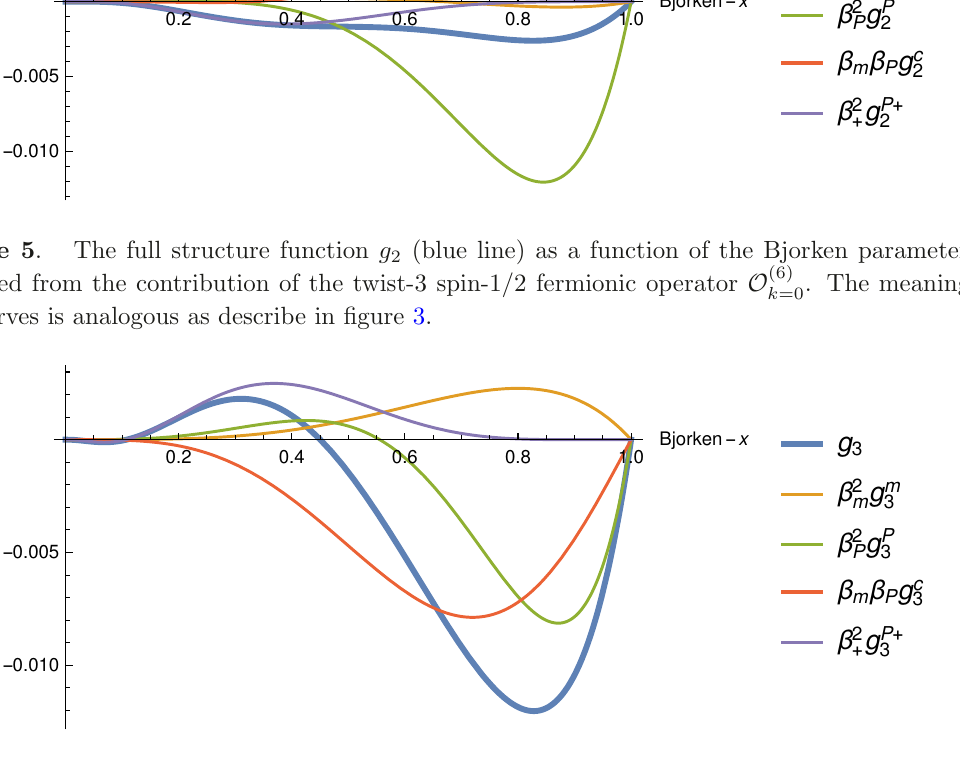
Figure 6 . The full structure function g 3 (blue line) as a function of the Bjorken parameter x , obtained from the contribution of the twist-3 spin-1/2 fermionic operator the curves is analogous as describe in figure